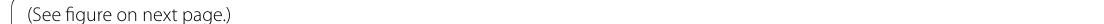
Fig. 6 Changes of XRD patterns during the back-transformation in bridgmanite. a Amorphization of bridgmanite with increasing temperatures from 410 to 610 °C at ~ 1.2 GPa (Run M2619). b Crystallization of orthoenstatite from amorphous bridgmanite at 1.1 GPa and 770 °C